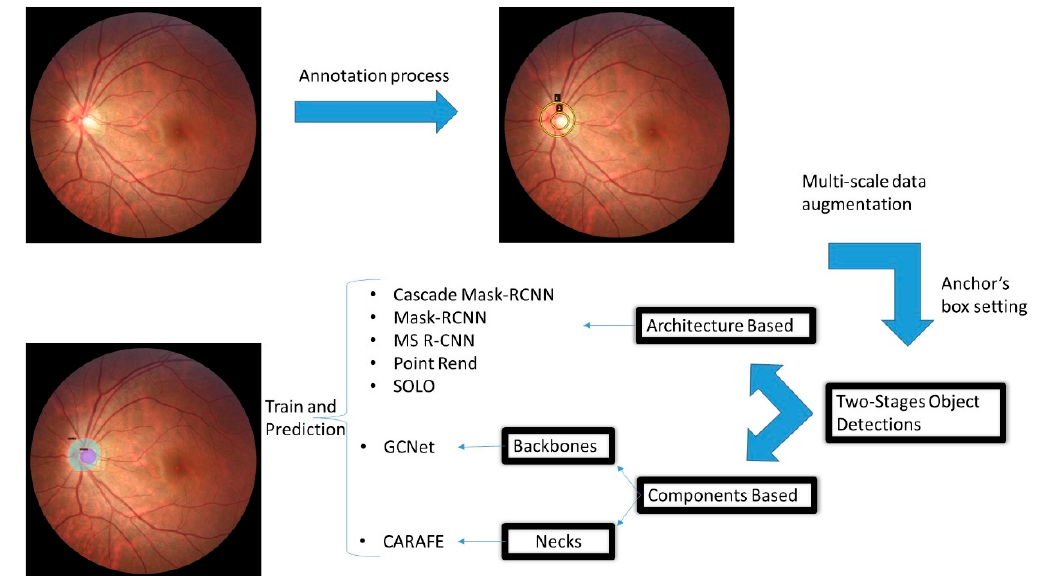
Figure 3. Workflow in the proposed investigation. In the annotation process, the ellipse with the number 1 is related to the disc class, and ellipse two is related to the cup class. number 1 is related to the disc class, and ellipse two is related to the cup